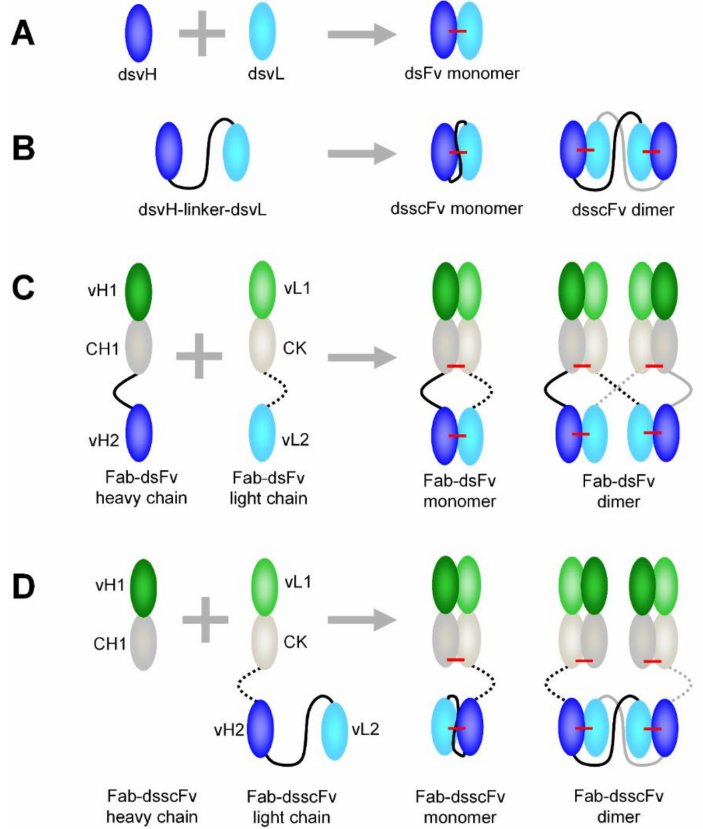
Figure 1. Potential dimerisation mechanisms of isolated and Fab-linked dsFv and dsscFv during cellular expression. ( A ) dsFv; ( B ) dsscFv; ( C ) Fab-dsFv; ( D ) Fab-dsscFv. Disulphide bonds are